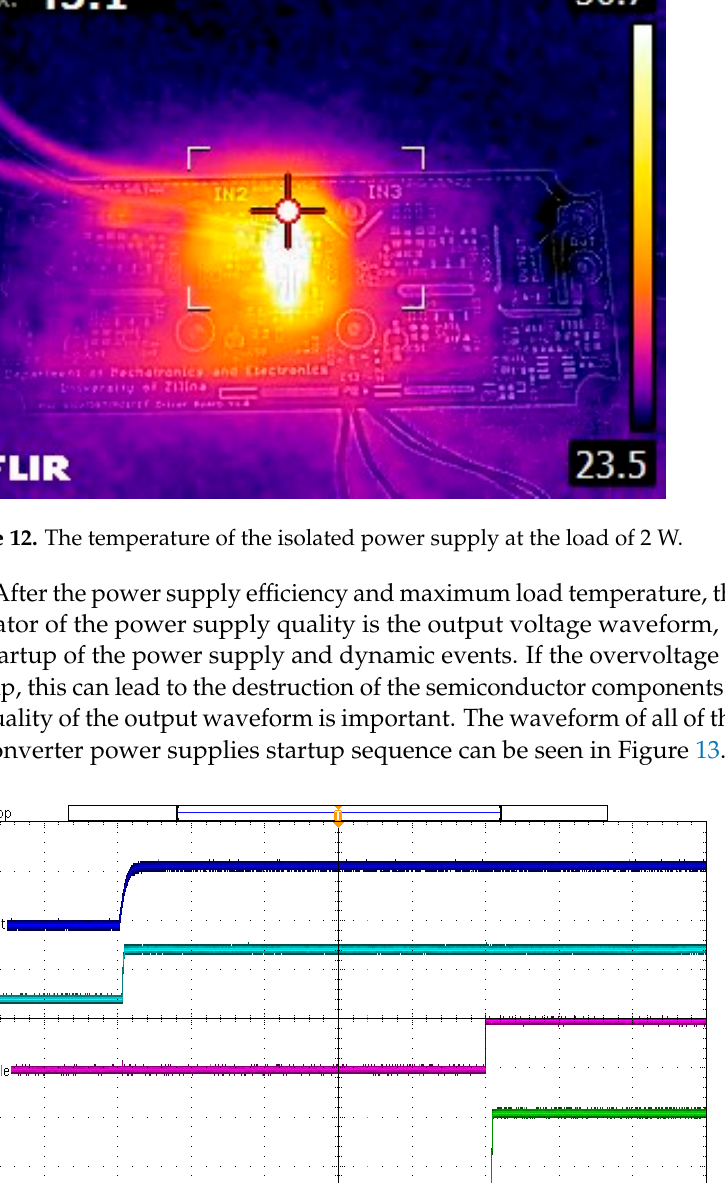
Figure 13. Power supply startup sequence (Input Voltage, Blue 10 V/div; 5 V Rail, Cyan 5 V/div; Enable Signal, Purple 5 V/div; Isolated Output, Green 10 V/div). The Input signal represents the 12 V supply rail provided by the laboratory power supply. The 5 V rail is measured at the output of the buck converter. The Enable signal represents the signal from the supervisor circuit monitoring the 5 V rail. Finally, the Isolated signal is the voltage at the secondary side of the isolated power supply for the gate drivers. supply occurs after enabling signal when the 5 V supply rail is present and